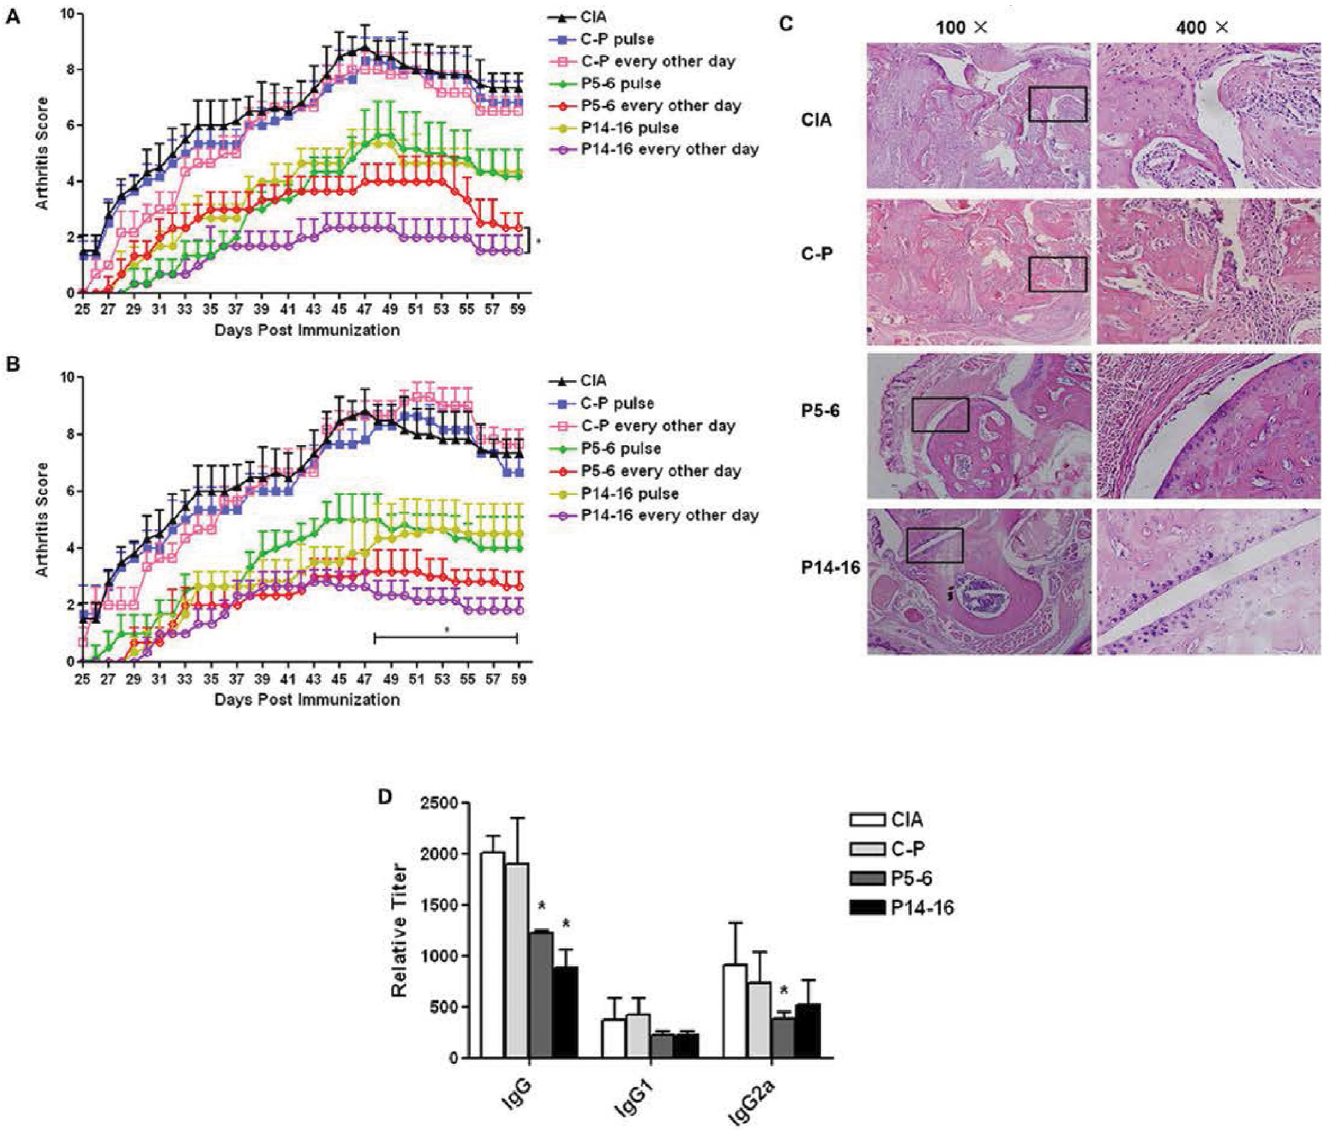
Figure 2. Preventive and therapeutic effects of ergotope peptides on CIA. Mice were randomly divided into seven groups, eight mice in each: CIA, control peptide treated (C-P), peptides 5–6 (P5–6) and peptides 14–16 (P14–16). Two different modes of administration were applied in all treated groups. The pulse administration regimen was giving 1000 μ g peptide in 500 μ l volume through intraperitoneal injection at 14 d before first immunization for prevention (A), or at 7 d post first immunization for treatment (B), while every-other-day ad- ministration was giving 200 μ g peptide in 200 μ l volume intraperitoneally five times starting 14 d before first immunization for prevention, or 7 d after first immunization for treatment (B). Mice in the CIA group were injected in the same way as control, with the same volume of sterile PBS every other day. (A and B) Clinical scores were assessed daily. Data are represented as mean ± SD (mice/group). *: P < 0.05, P14–16 every other day versus P5–6 every other day. (C) Histopathological changes of joints were examined in the CIA group, C-P treated group, and P5–6 and P14–16 every-other-day groups on d 45. Representative sections stained with hematoxylin and eosin in each group (B) are shown (left panel, × 100; right panel, × 400). (D) The levels of IgG, IgG1 and IgG2a in sera were measured by ELISA at the peak of disease in the groups described in (C). Data are represented as mean ± SD. *: P < 0.05, versus C-P group. Data are representative of three separate experiments with similar